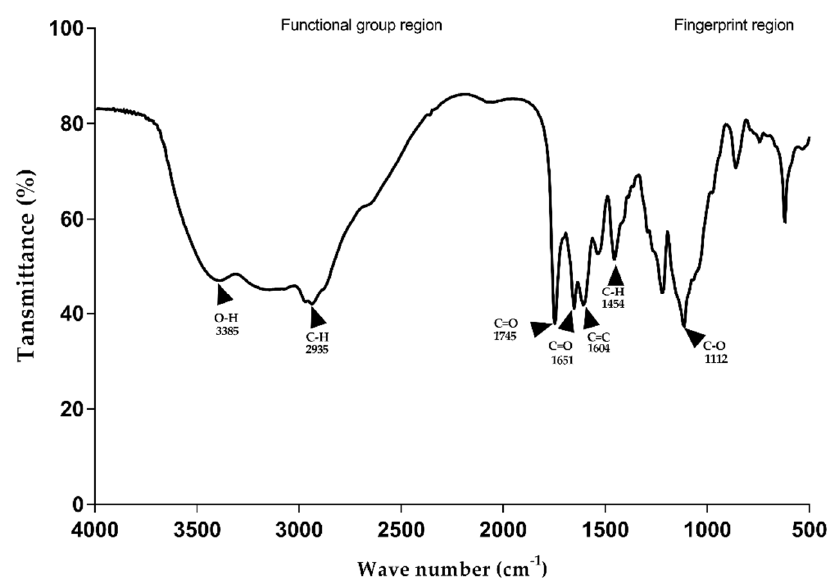
Figure 5. Investigation of the functional group of coprogen B from T. marneffei ∆ sreA strain by FTIR. FTIR analysis of the siderophore shows the presence of hydroxyl group (O-H stretching at wavenumber 3550–3200 cm − 1 ), ester group (C=O stretching at wavenumber 1745 cm − 1 ), amide group (C=O bending at wavenumber 1651 cm − 1 ), and alkene (C=C stretching at wavenumber 1604 cm − 1 ). The purified siderophore was analyzed with NMR spectroscopy to confirm its struc- ture. 1 H-NMR and 13 C-NMR spectra of an unbound form of siderophore were measured